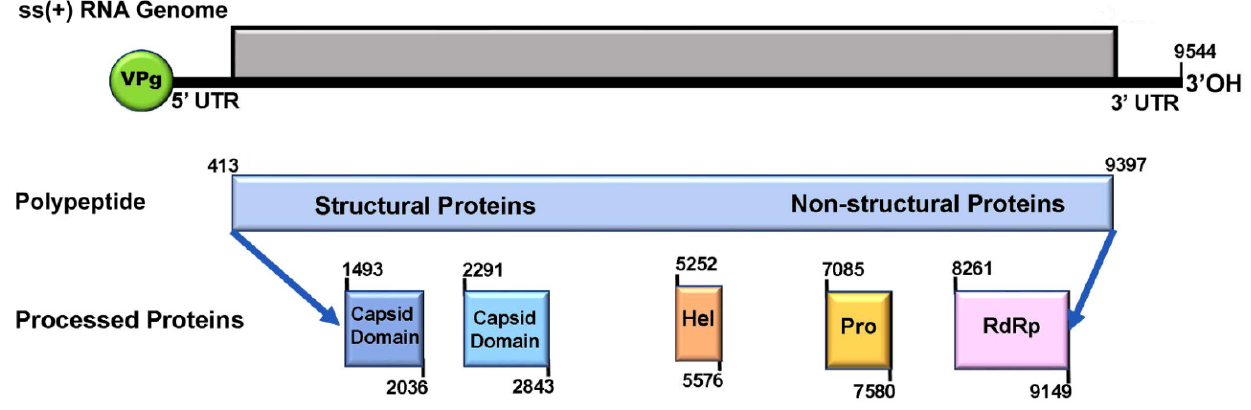
Figure 1. Schematic representation of the Varroa destructor virus-2-China (VDV-2-China) genome organization. The non-structural and structural proteins are encoded by a single open reading frame (ORF) and expressed as a polypeptide. The approximate positions of the helicase (Hel), protease (Pro), and replicase (RdRp) domains in the non-structural proteins encoded by 3 ′ end of ORF and the major capsid proteins domains in the structural proteins encoded by 5 ′ end of ORF are shown. The protein domains were defined by pairwise amino acid sequence alignment between VDV-2-China and VDV-2-UK (QFS19921) whose functional regions have been identified and annotated and further confirmed by Pfam matches.